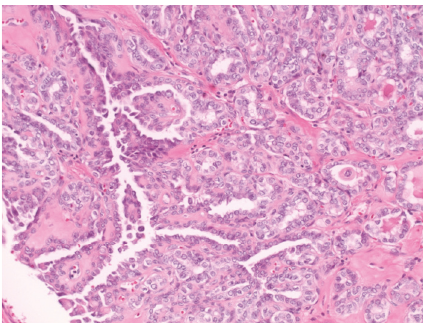
Figure 5: The proliferative tumor is characterized by complex and arborizing papillary fronds (H&E stain, 200x original magnifica- tion).